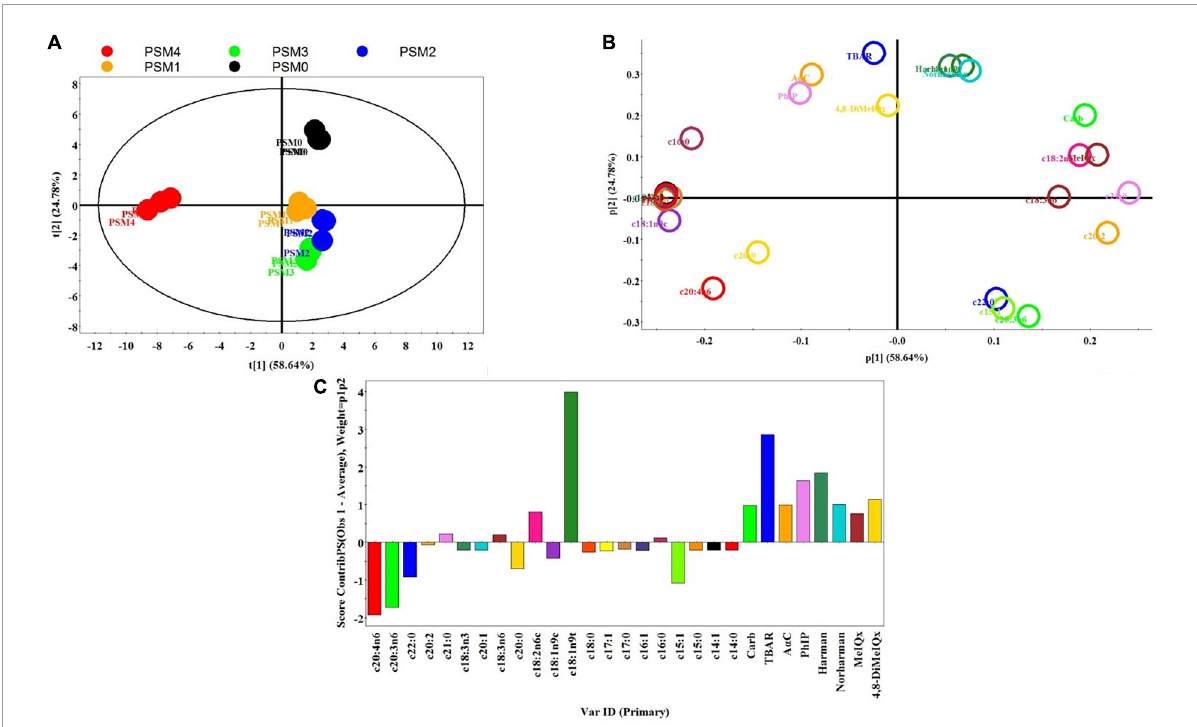
FIGURE2 Principal component analysis; (A) , score plot (PC1 versus PC2) (B) , loading plot (C) , contribution plot of HCAs, TBARS, carbonyl and fatty acid profiles of pan-fried chicken patties incorporated with different levels of Perilla seed meal (PSM) as a fat substitute. PSM 0% + fat 20%